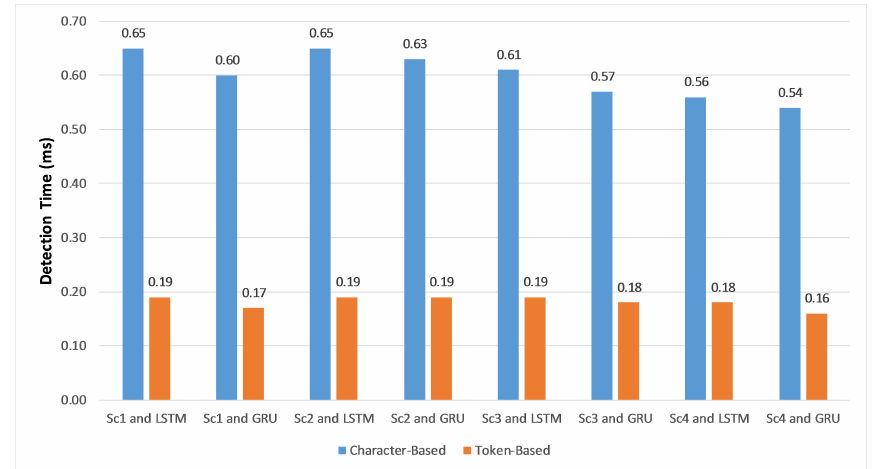
Figure 6. Detection times of the proposed approach on a GPU system using character-based and token-based feature